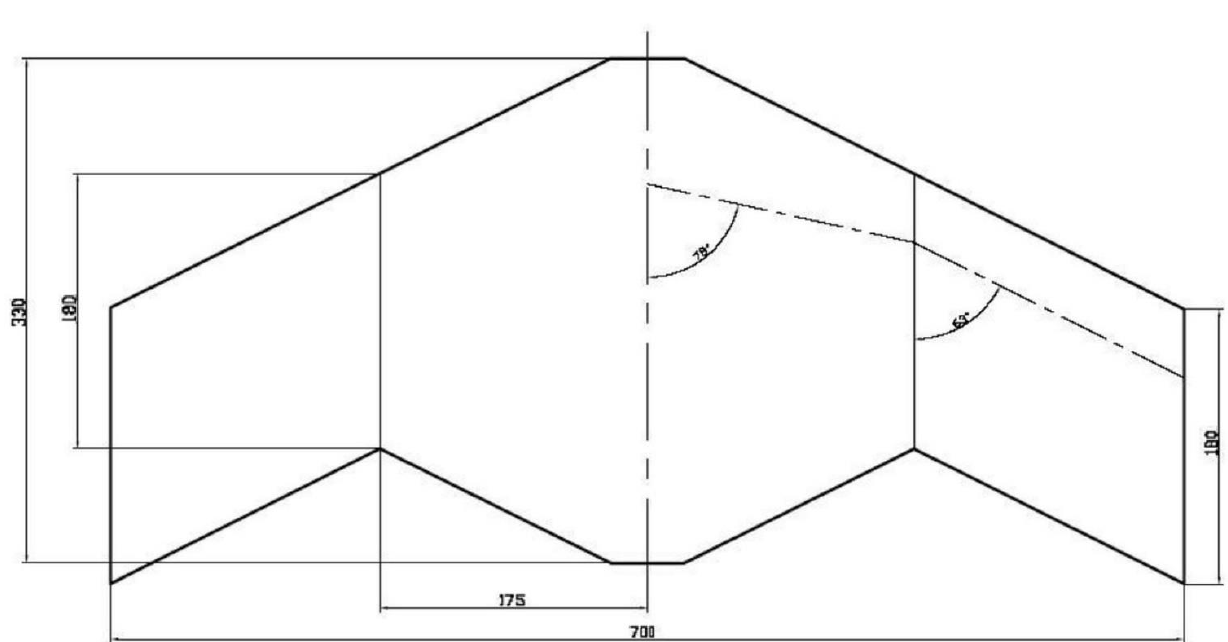
Figure 9. Double Delta (PD) airplane.